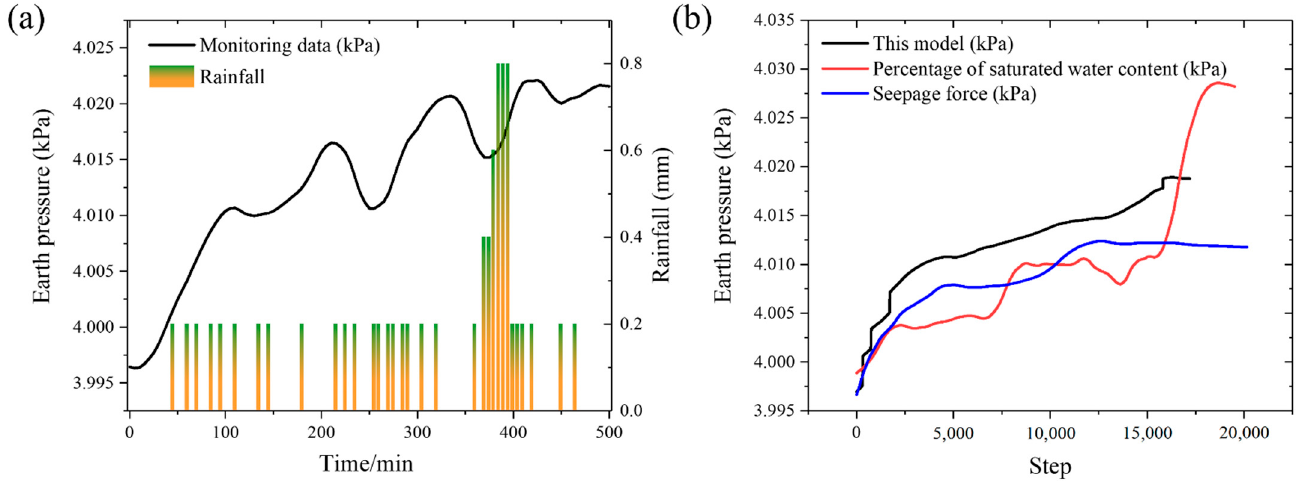
Figure 8. Comparison of the soil pressure results obtained by the three models. ( a ) The monitoring data; ( b ) The simulated data from three models. data; ( b ) The simulated data from three